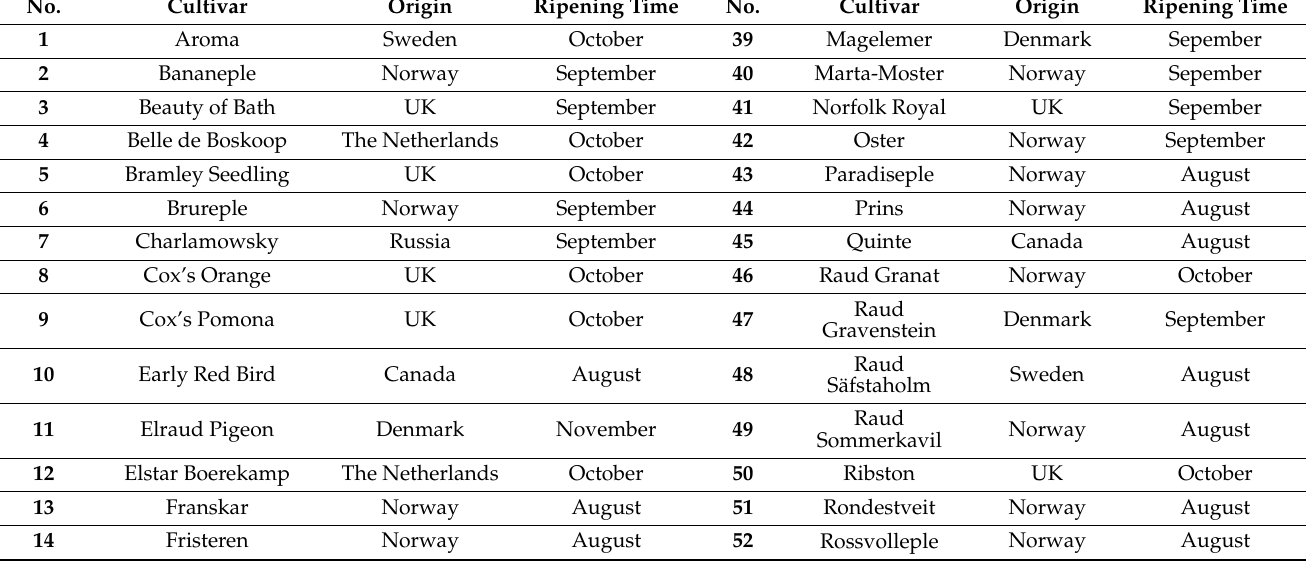
Table 1. Investigated apple cultivars, country of origin, and ripening